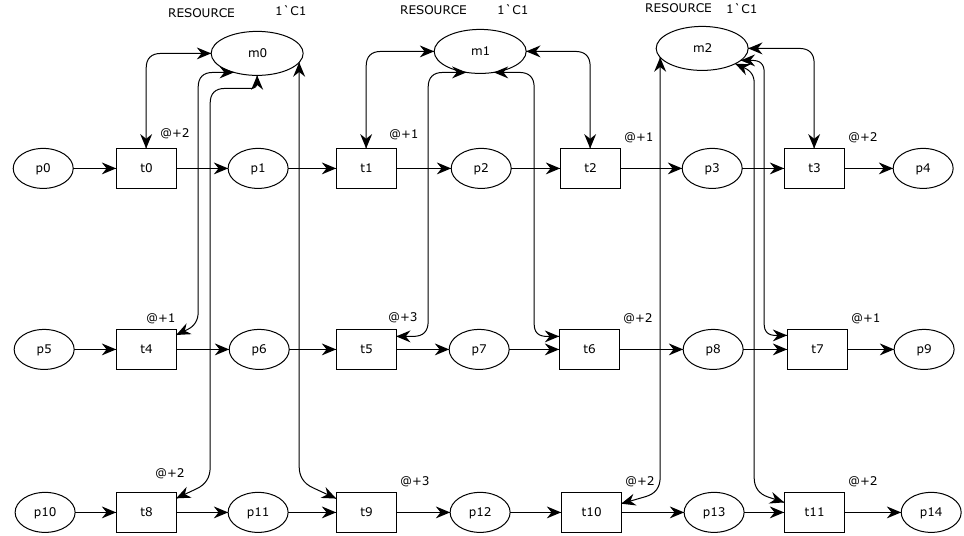
Figure 6. Colored Timed Petri Net Model for Job-Shop Scheduling created by using CPNTools [24].